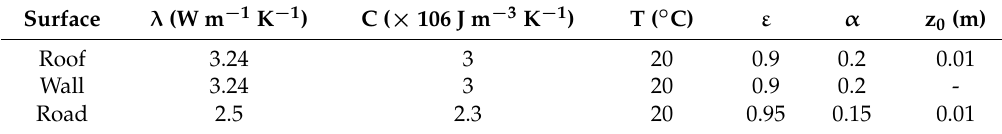
Table 2. Thermal parameters used in the single-layer urban canopy model (SLUCM) for every urban class. λ is the thermal conductivity of the material, C is the specific heat of the material, T(int) is the initial temperature of the material and also the temperature of the deepest layer, ε is the emissivity of the surface, α is the albedo of the surface, and z 0 is the roughness length for momentum over the surface.